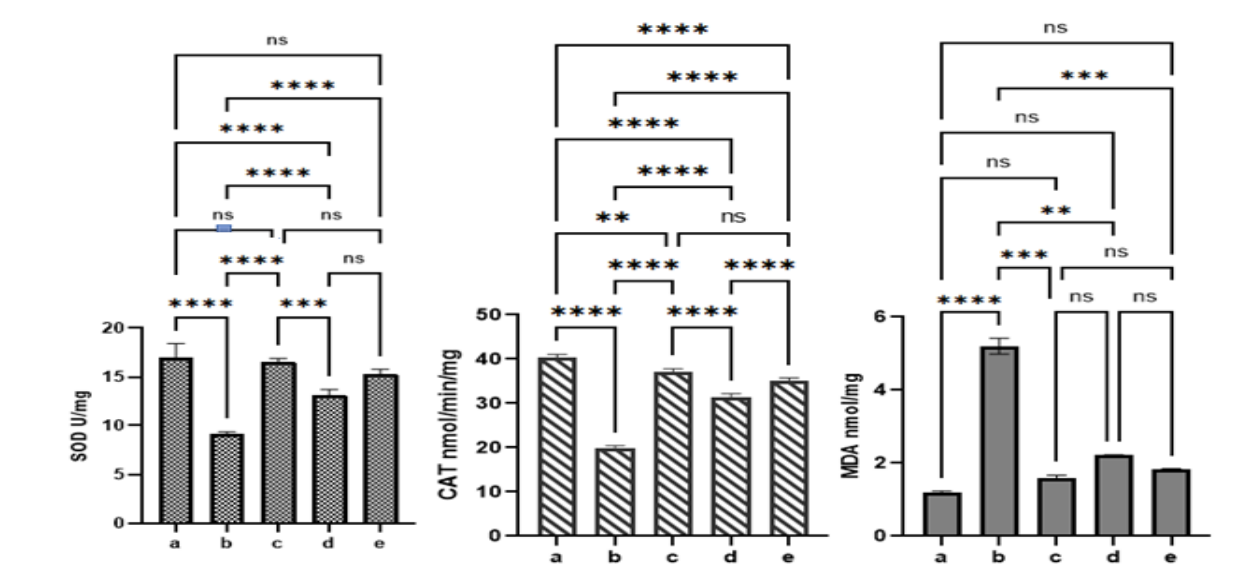
Figure 5. Effects of A. muricata extracts on antioxidant enzyme activities (SOD and CAT) and MDA levels in the liver. Data expressed as mean ± SEM. Means among groups ( n = 6 rate/group) show the significant differences examined using one-way ANOVA and Tukey’s post hoc multiple comparisons test. **** p < 0.0001, *** p < 0.001, ** p < 0.005 above columns specify significant differences from the normal control group and above lines for the differences between treated groups. ns p > 0.05 denotes non-significant differences. a. Normal Control, b. TAA Control (200 mg/kg), c. Silymarin (50 mg/kg) + TAA, d. A. muricata (250 mg/kg) + TAA, e. A. muricata (500 mg/kg) +